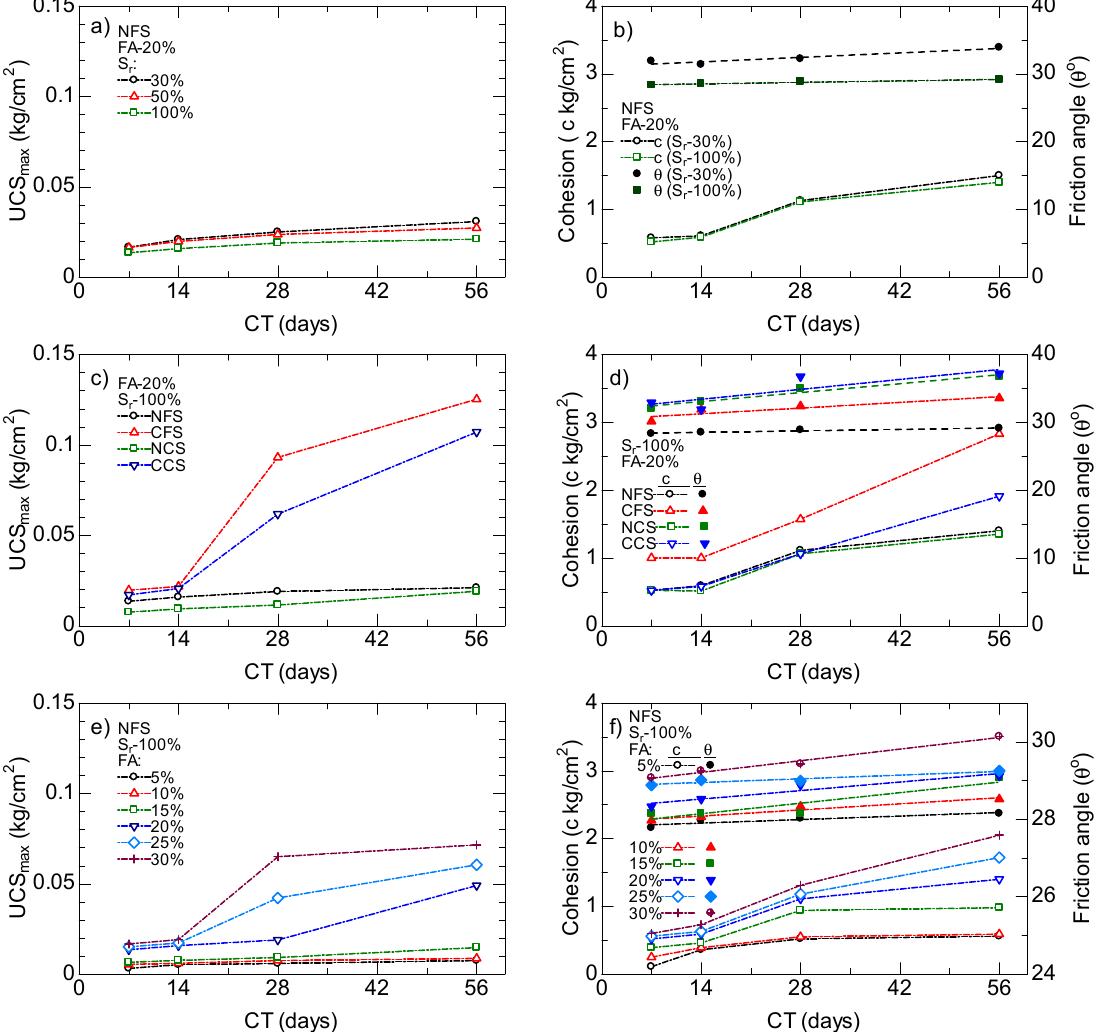
Figure 5. The effect of curing time on the mechanical properties of fly-ash-stabilized sands. ( a ) UCS max -CT relationship of NFS at various S r with 20% FA, ( b ) shear strength parameters-CT relationship of NFS at different S r with FA 20%, ( c ) UCS max -CT relationship of dissimilar sands with S r -100% and 20% FA, ( d ) shear strength parameters-CT relationship of diverse sands with S r -100% and 20% FA, ( e ) UCS max -FA relationship of NFS at various FA with S r -100%, ( f ) shear strength parameters-FA relationship of NFS at any kinds of FA with S r -100%.